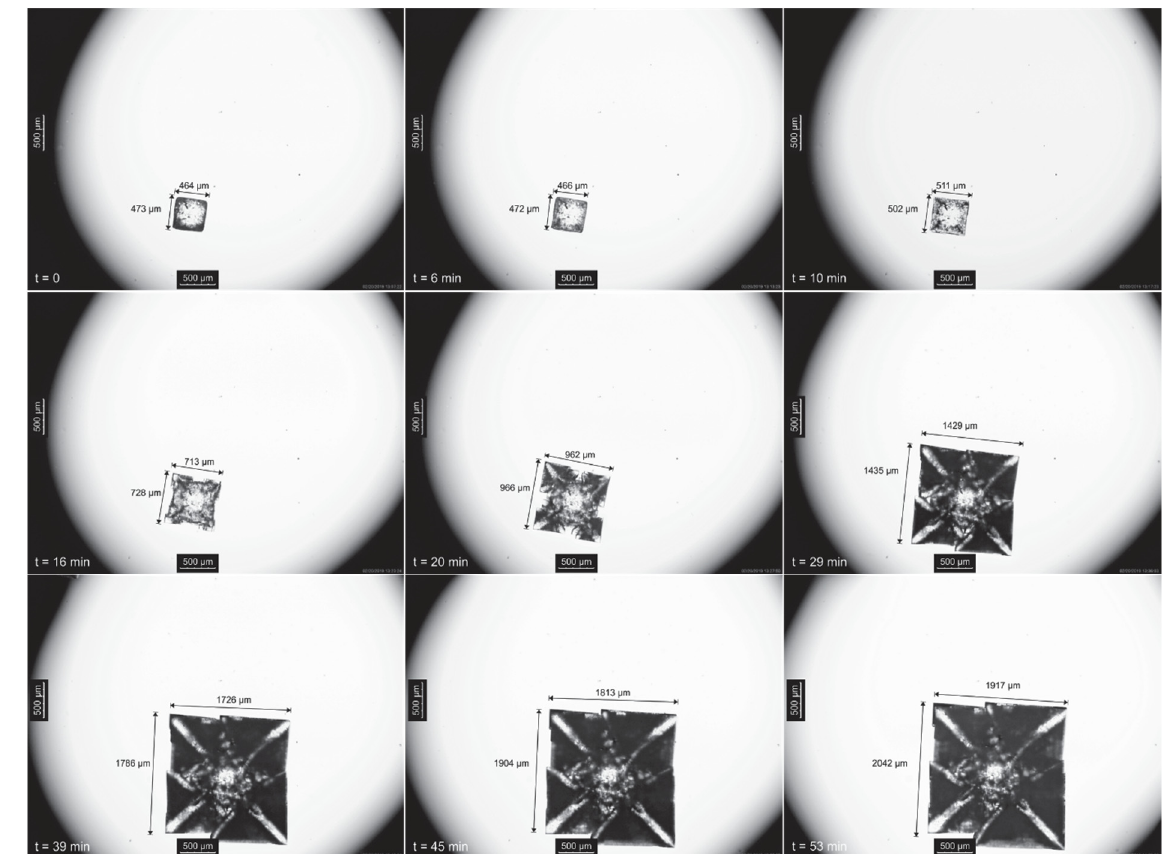
Figure 11. Optical photomicrographs along time of the NaCl–CaSO 4 –H 2 O droplet under evaporation seeded with NaCl.